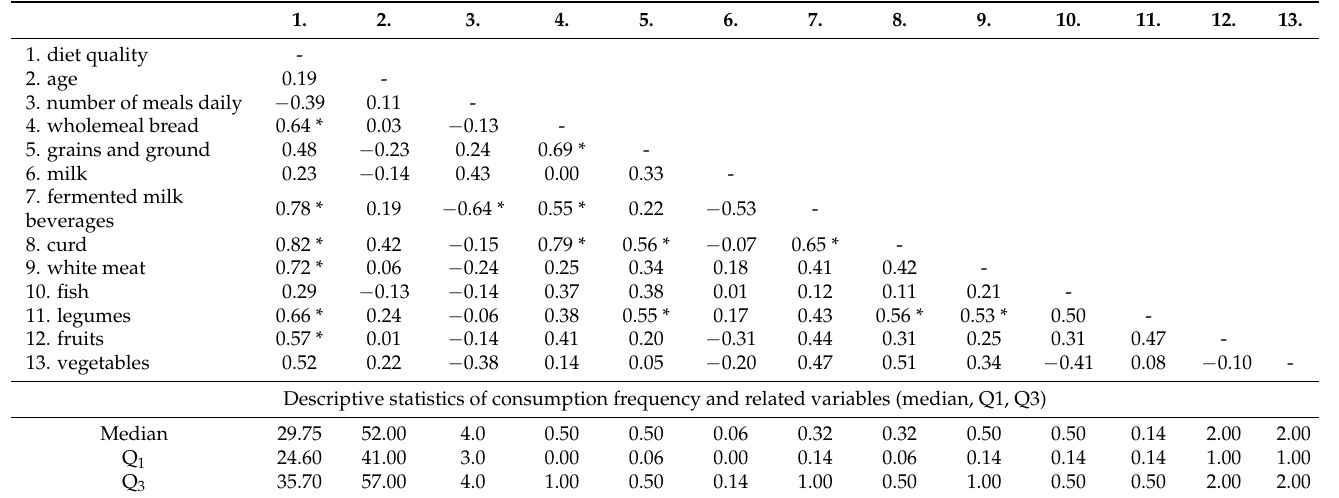
Table 3. Determinants of diet quality of masters athletics from France.